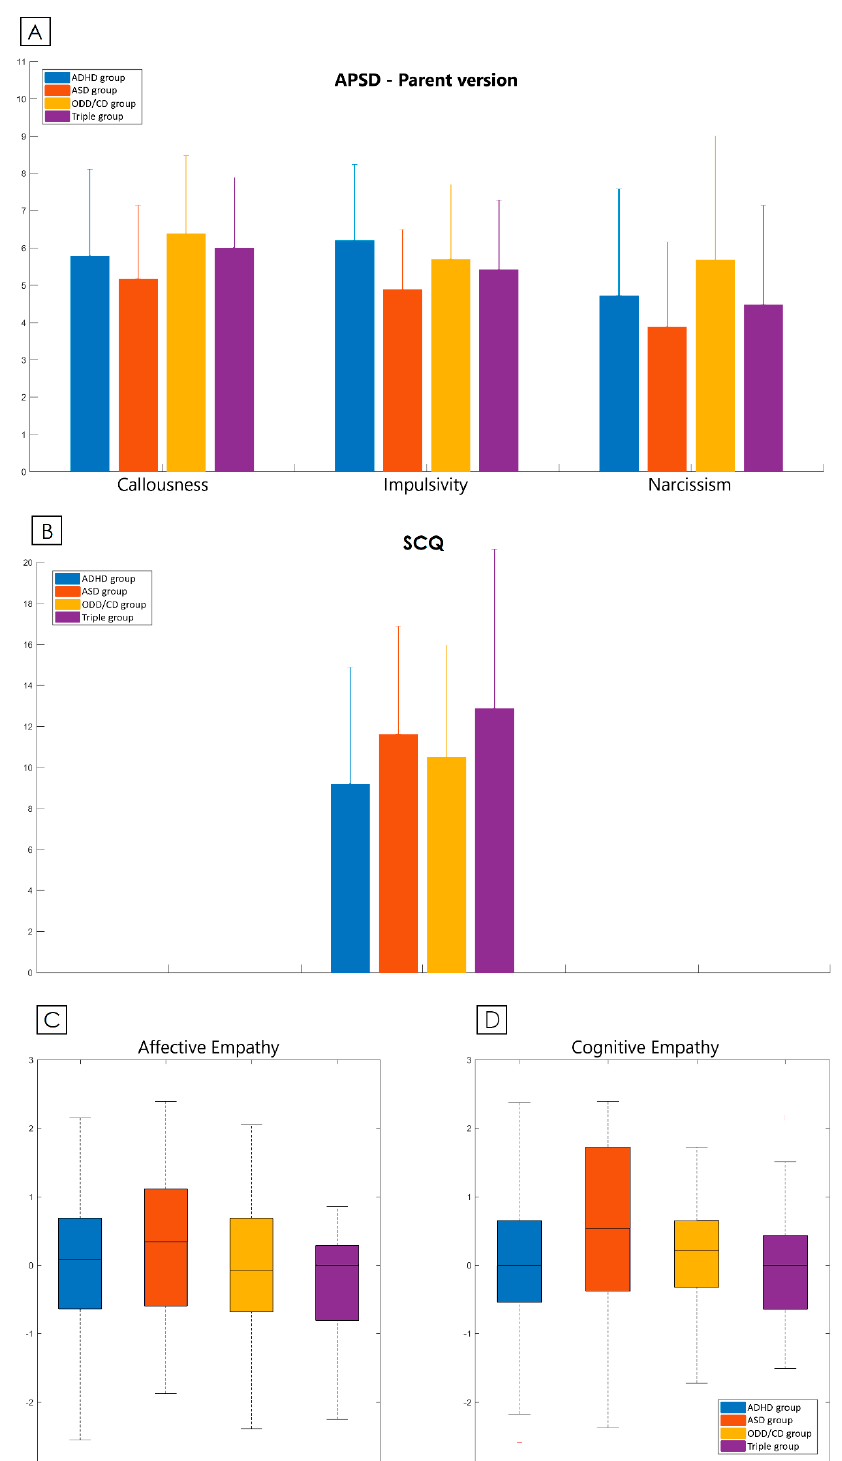
Figure 1. Questionnaires. Scores obtained by the four clinical groups in the Antisocial Process Screening Device (APSD, ( A )), the Social Communication Questionnaire (SCQ, ( B )) and the merged Empathy Questionnaire ( C ) are here illustrated. Scores are compared between ADHD group (blue bars), ASD group (red bars), ODD/CD group (yellow bars) and Triple group (purple bars). Graphs represent means with standard deviation bars, except for ( D ) where boxplots represent medians and first and third quartiles with minimum/maximum bars. * p -values < 0.05, ** p- values < 0.01, *** p- values < 0.001.